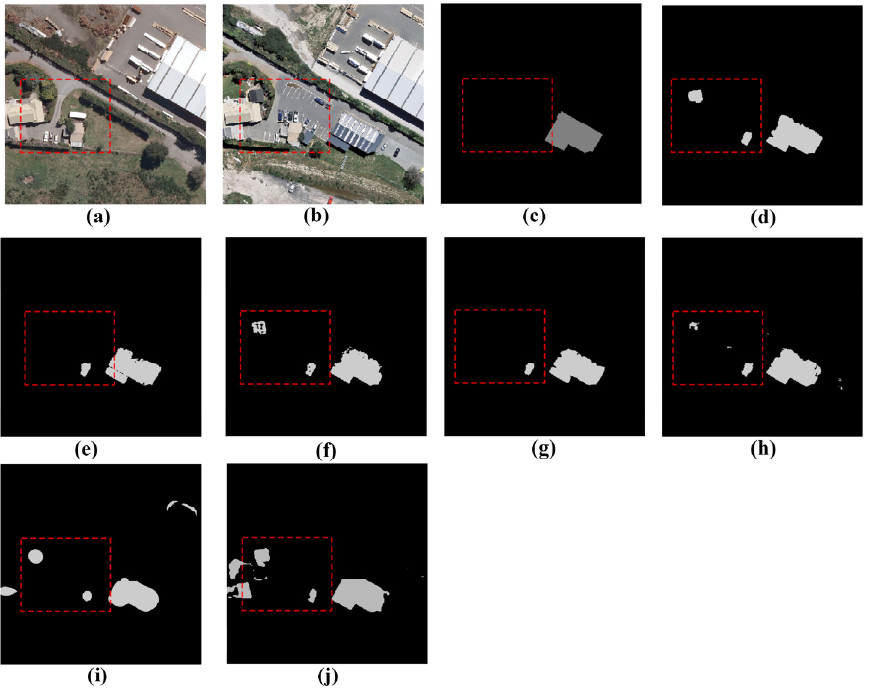
Figure 10. ( a ) Before image. ( b ) After image. ( c ) Label. ( d ) FC-EF. ( e ) FC-Siam-conc. ( f ) FC-Siam-diff. ( g ) SegNet. ( h ) DASNet. ( i ) STANet. ( j ) Ours.